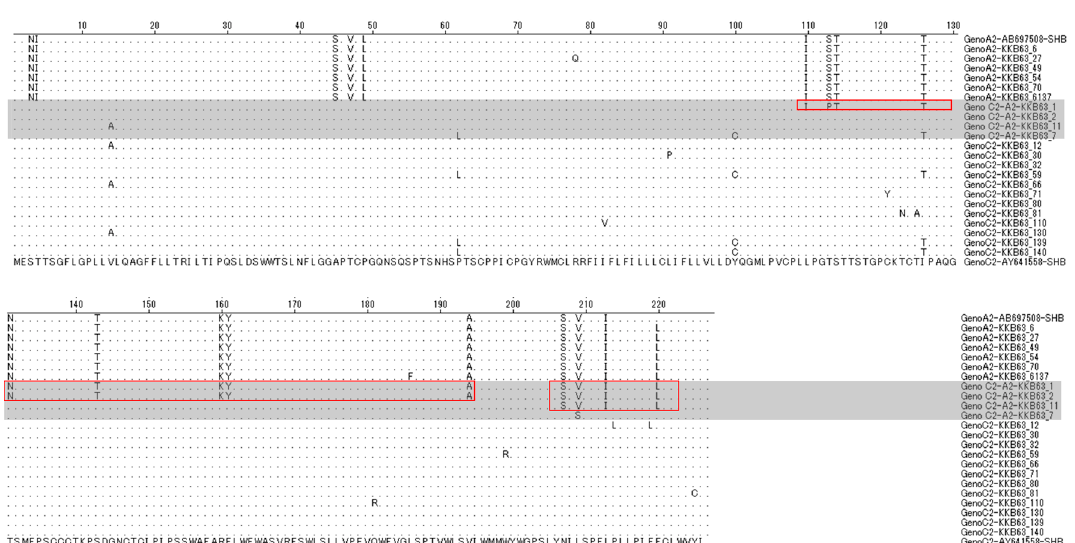
Figure 3. Alignment of the overlapping HBsAg regions of the 22 clones and the reference strains of genotypes A2 and C2. The three recombinants KKB63-1, KKB63-2 and KKB63-11 had recombination breakpoints in HBsAg at the amino acid positions 110, 131 and 207, respectively. The amino acids which matched with the reference strain of genotype C2 were hidden. The alignment was performed by MegAlign software with Jotun Hein Method (Windows. Version 3.12e, DNASTAR, Madison, WI, USA).